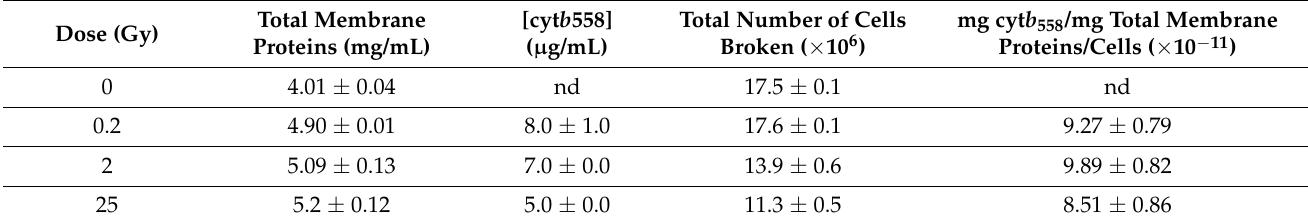
Table 2. Determination of cyt b 558 amount in plasma membranes isolated from irradiated and non- irradiated PLB-985 cells Cyt b 558 contents in the plasma membrane were estimated from the difference absorption spectra and the total membrane proteins (tMP) were determined using BCA assay. Data are mean ± SEM of two independent experiments. Nd: not determined.